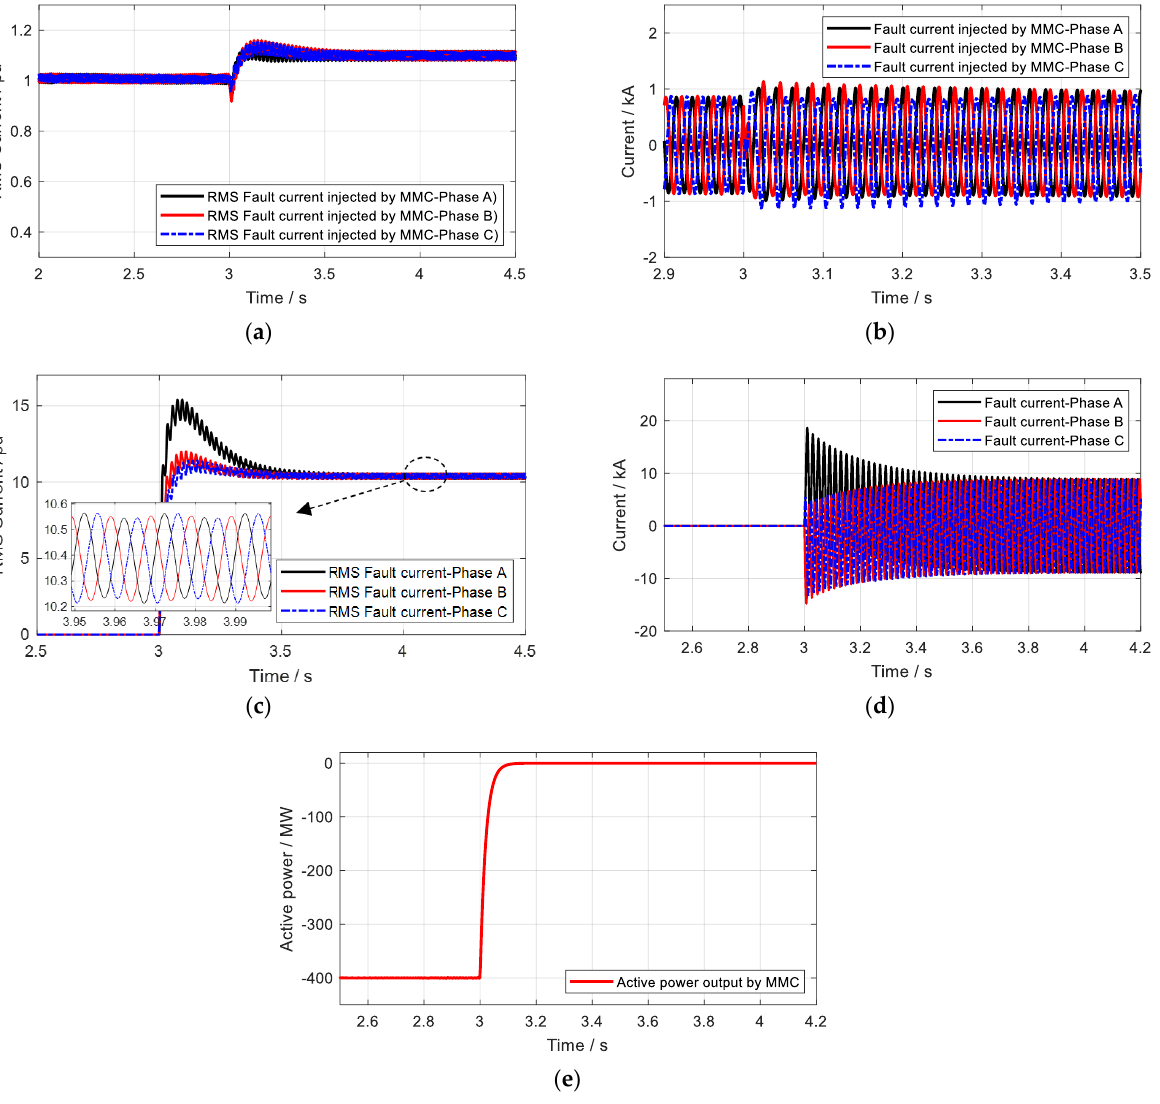
Figure 13. The simulation situations in case 3. ( a ) The RMS short-circuit current injected by the MMC after the fault. ( b ) The instantaneous short-circuit current injected by the MMC after the fault. ( c ) The RMS short-circuit current of the whole system after the fault. ( d ) The instantaneous short-circuit current of the whole system after the fault. ( e ) The active power transmitted by the MMC.